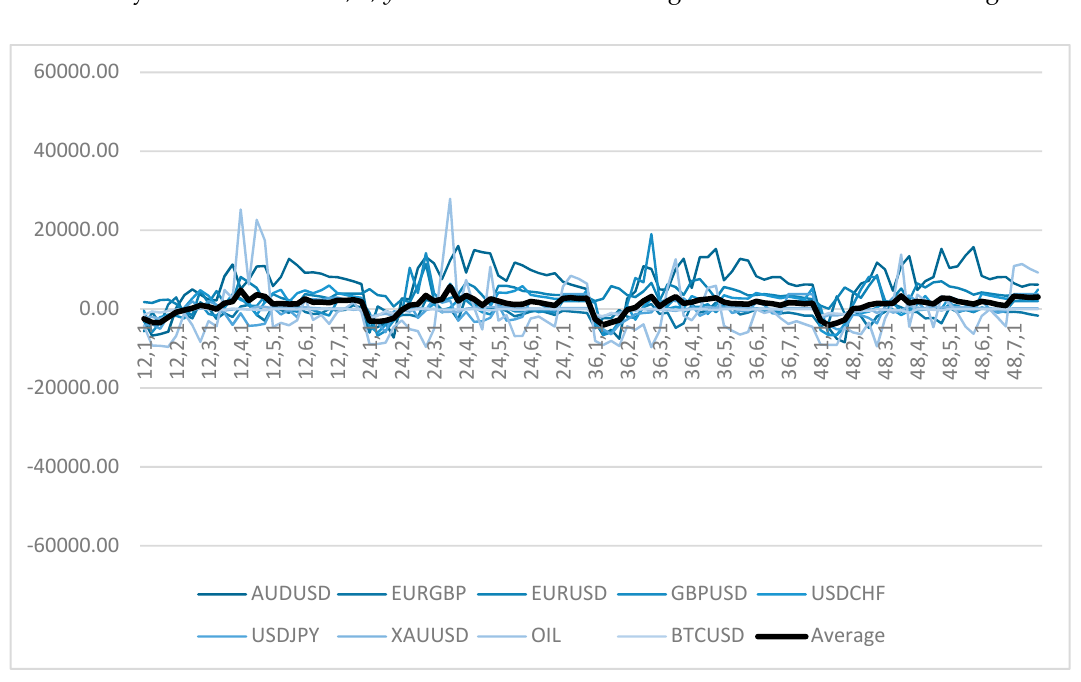
Figure 11. Drawdown, as percentage of equity, of experiment (e) for various values of N.